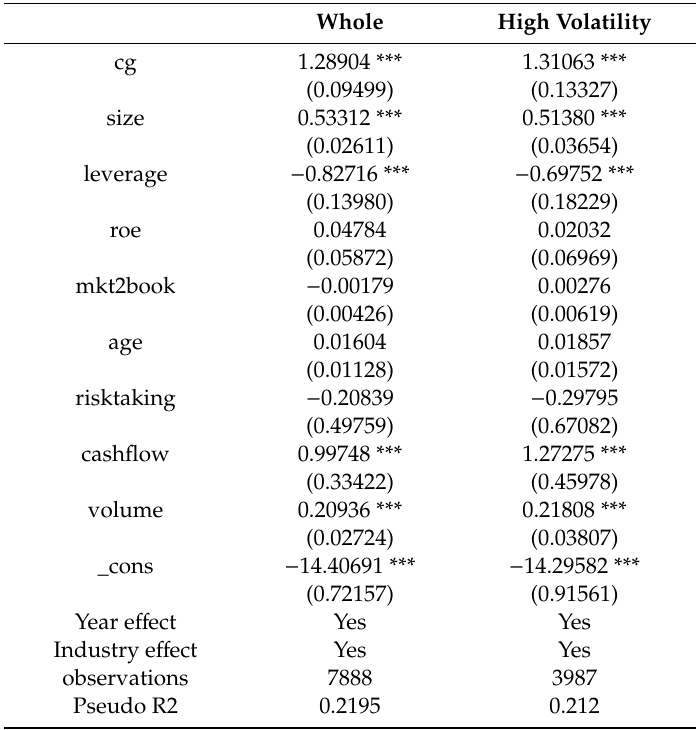
Table 5. Propensity score matching. Panel A: Probit Estimation Result for Propensity